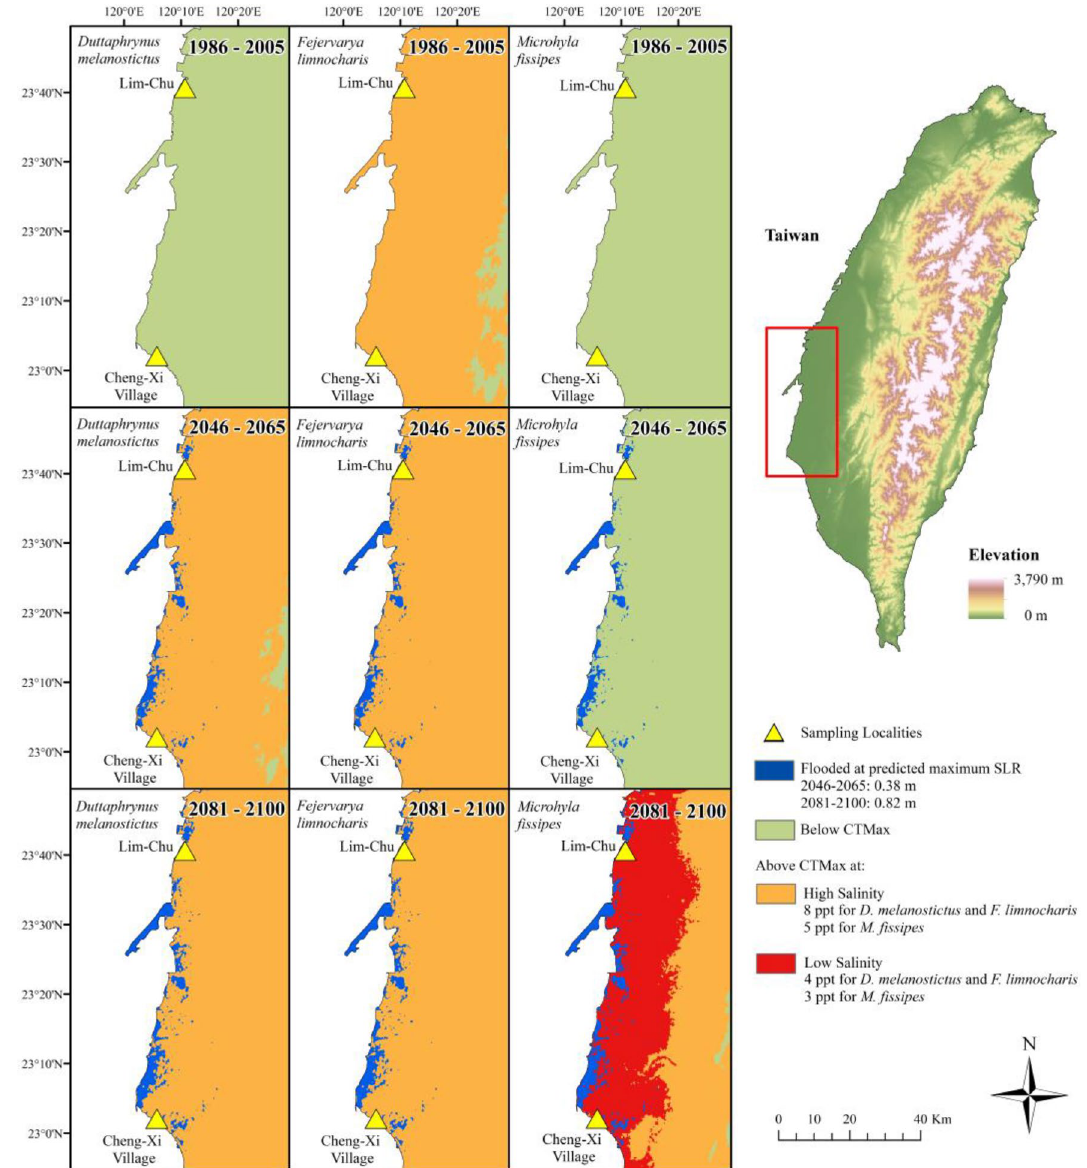
Figure 6. Current and future conditions for three species ( Duttaphrynus melanostictus , Fejervarya limnocharis , and Microhyla fissipes ). Conditions were compared by classifying maximum temperature into CTmax values at low and high salinity. While CTmax for high salinity is only reached for F. limnocharis at conditions for 1986– 2005, climatic predictions for 2046–2065 indicate CTmax for high salinity will be reached for D. melanostictus and F. limnocharis . The climatic predictions for 2081–2100 indicate CTmax for high salinity will be reached for all species, and CTmax for low salinity will be reached for M. fissipes . Maps were generated by D. Andersen under ArcMap 10.6 (ESRI, Redlands, CA,